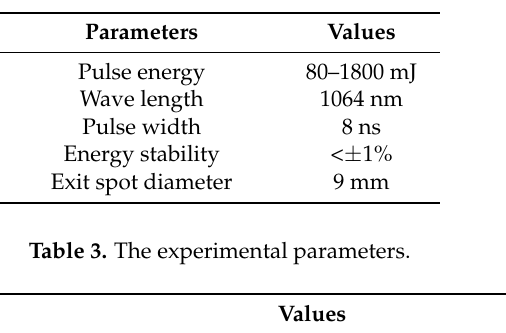
Table 2. Main parameters of Spitlight 2000 Nd:YAG Laser.